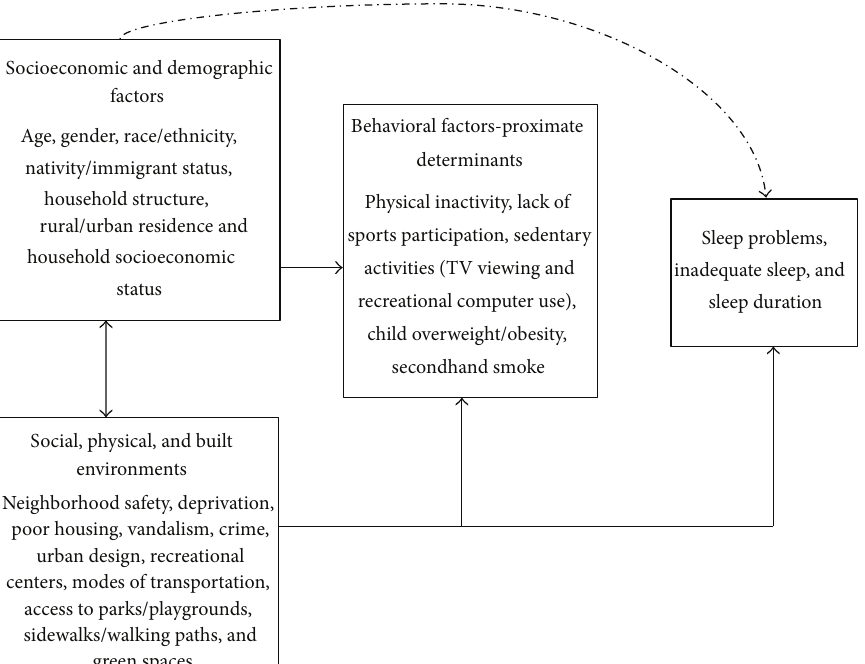
Figure 1: A simple model of neighborhood and sociobehavioral determinants of sleep problems in children and